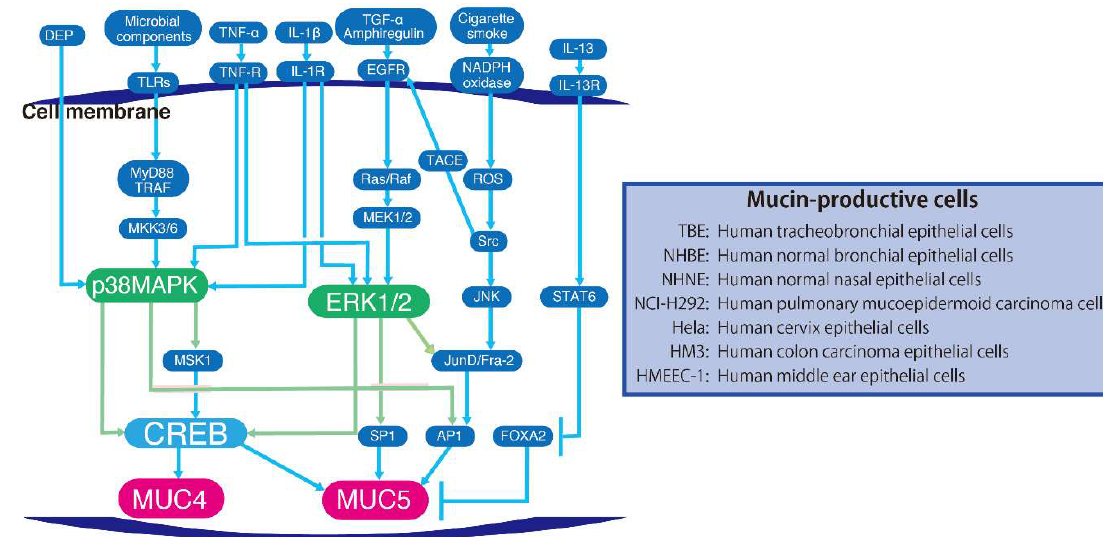
Figure 3. Regulation of the mucus production by MAPK signalling. Multiple stimuli induce phosphorylation of MAPKs following activation of transcriptional factors and production of mucus. IL-13 increases MUC5AC expression by indirect mechanisms including STAT6 phosphorylation through FOXA2 suppression.